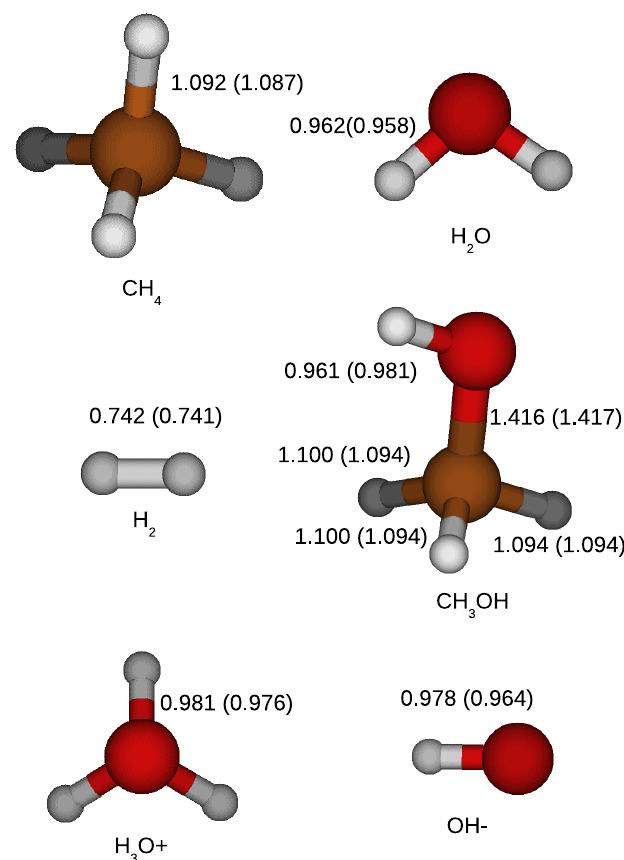
Figure 1. Calculated geometries of molecules. Red, gray, and brown solid circles correspond to an oxygen atom, a hydrogen atom, and a carbon atom, respectively. Atoms are chemically connected with one another with a bond. The numbers next to a bond are the calculated bond length in the unit of Å with that determined by experiments [37–42] in a